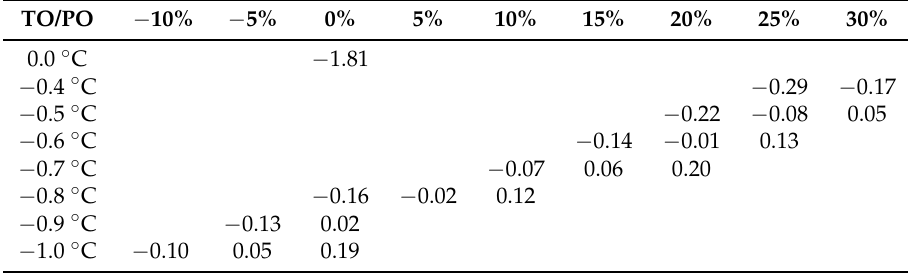
Table 3. Precipitation (PO) and air temperature offsets (TO) are combined to simulate steady-state conditions (m w.e. a − 1 ) for the recent extent of Schiaparelli Glacier.